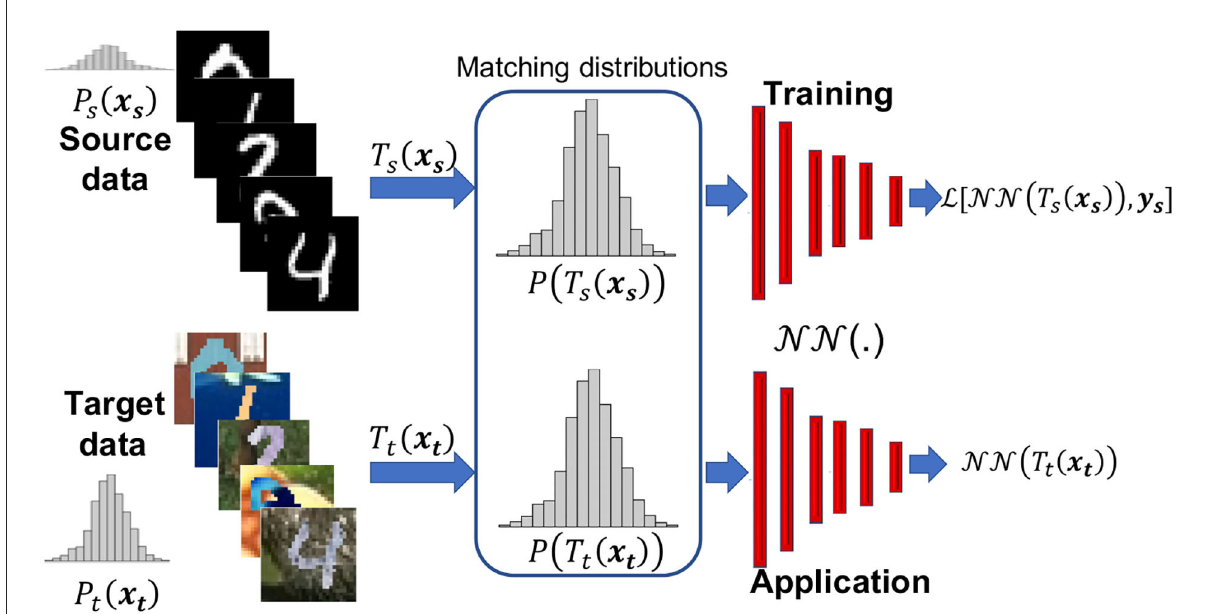
FIGURE1 The motivation behind the proposed data adaptation in which the training (source) dataset might have a different distribution than the application (target) dataset, in which transformations T s and T t will help reduce such difference and provide new input features to the neural network function ( NN ) to train the network to reduce loss L , and then apply to real data. Here, P is the probability distribution and we show schematic versions of it for the source and target data, given by samples of the MNIST and MNIST-M datasets,